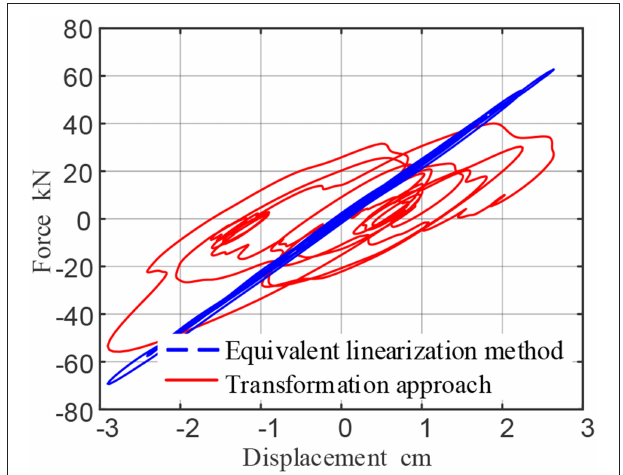
FIGURE 10 | Force-Displacement curve of viscoelastic resistance under seismic load (assuming working frequency 5Hz).